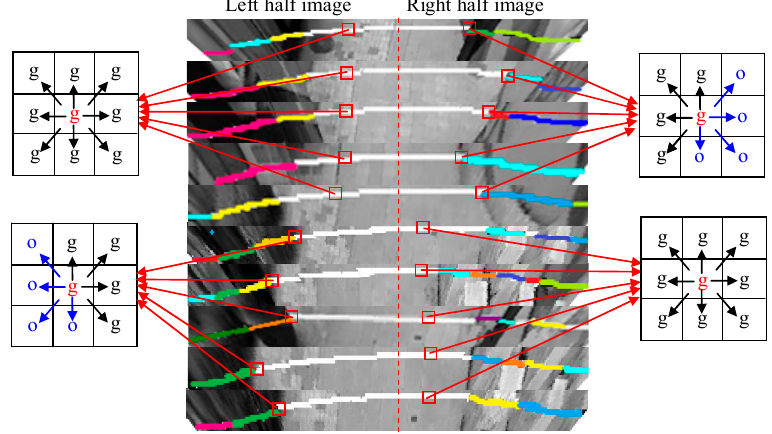
Figure 12. Spatial context comparison for the left half and the right half of the image.